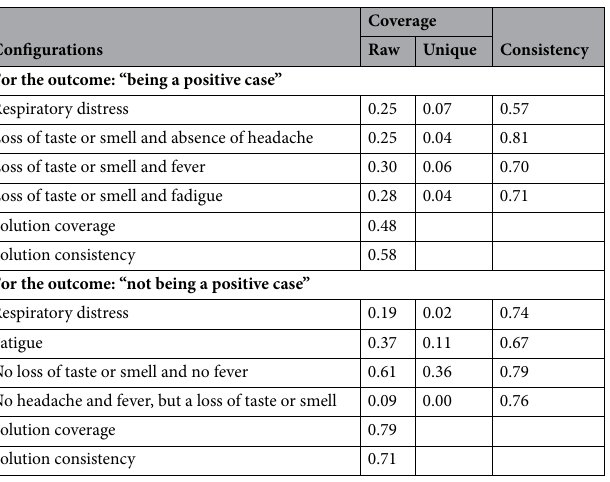
Table 2. Symptom configurations associated with positive and negative COVID-19